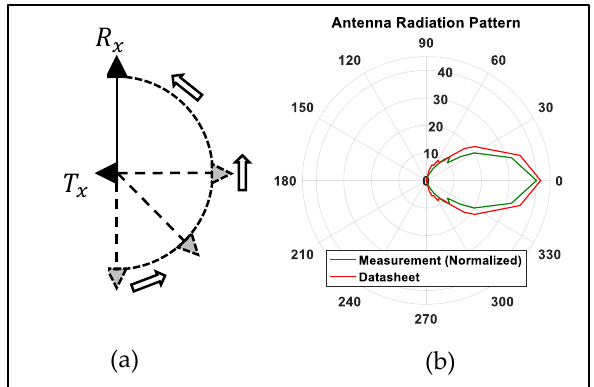
Figure 7. ( a ) Illustration of the measurement of antenna gains; ( b ) Comparison of the radiation patterns.